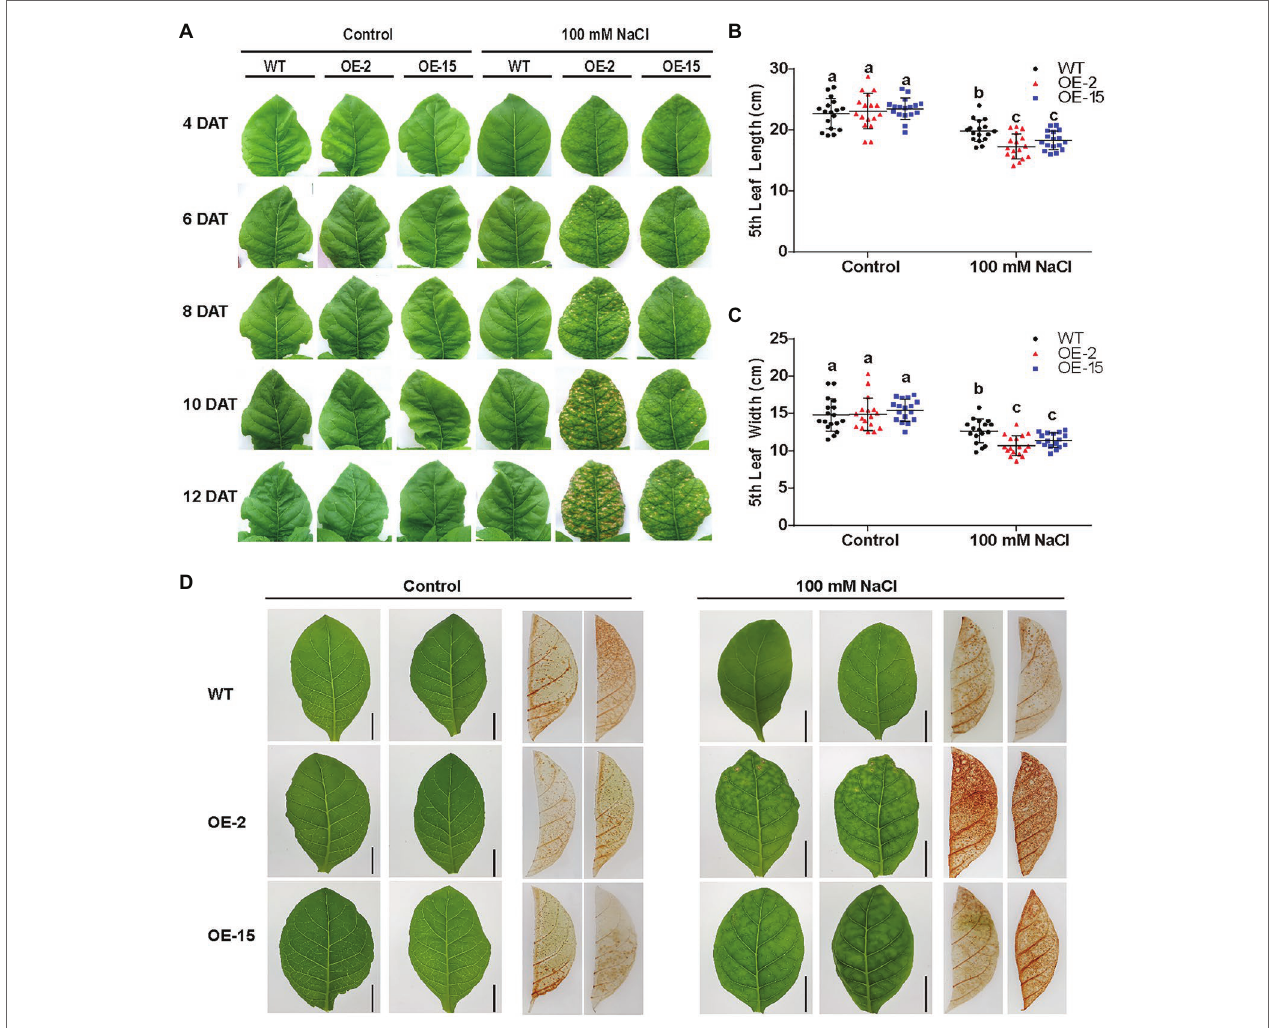
FIGURE 4 | The determination of physiological parameters in wild-type (WT) and NtCBL5A -overexpressing lines (OE-2 and OE-15). (A) The phenotype of the fifth leaf of WT and NtCBL5A -OE lines under control conditions and salt stress (100 mM NaCl) from 4 to 13 DAT. (B,C) Leaf length and leaf width determination of the fifth leaf at 8 DAT. (D) DAB staining of tobacco under control conditions and salt stress (100 mM NaCl) at 6 DAT. Error bars indicate ±SD ( n = 17), different letters above bars (a, b, and c) indicate significant statistical difference based on one-way ANOVA with LSD test ( p < 0.05). Scale bars = 2